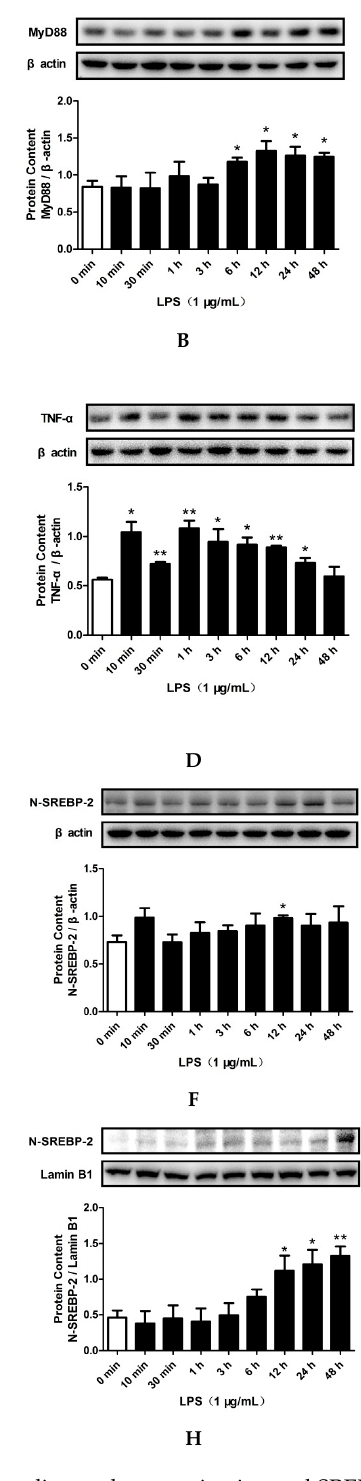
F Figure 2. Effects of LPS and PA on cholesterol content in HepG2 cells. Cells were treated with LPS (1 μ g/mL) or PA (200 μ mol/L) for different times (0 min, 10 min, 30 min, 1 h, 3 h, 6 h, 12 h, 24 h, and 48 h). Intracellular total cholesterol (TC) was determined with a commercial kit ( A , B ). Intracellular free cholesterol was visualized by filipin staining ( C , D ) and quantified using ImageJ and SPSS20.0 software ( E , F ). The results are presented as means ± SD of three independent experiments; *: p < 0.05 vs. 0 min, **; p < 0.01 vs. 0 min. 2.3. LPS and PA Treatments Increased TLR4/MyD88/NF- κ B Signaling Pathway Activation and SREBP-2 Expression To determine the effects of LPS and PA on cholesterol accumulation induced by SREBP-2 and inflammation caused by the TLR4/MyD88/NF- κ B signaling pathway, HepG2 cells were treated with LPS or PA for 0 min, 10 min, 30 min, 1 h, 3 h, 6 h, 12 h, 24 h, and 48 h. After that, the expression levels of SREBP-2 and key proteins of the TLR4/MyD88/NF- κ B signaling pathway were determined. As shown in Figure S1A, LPS